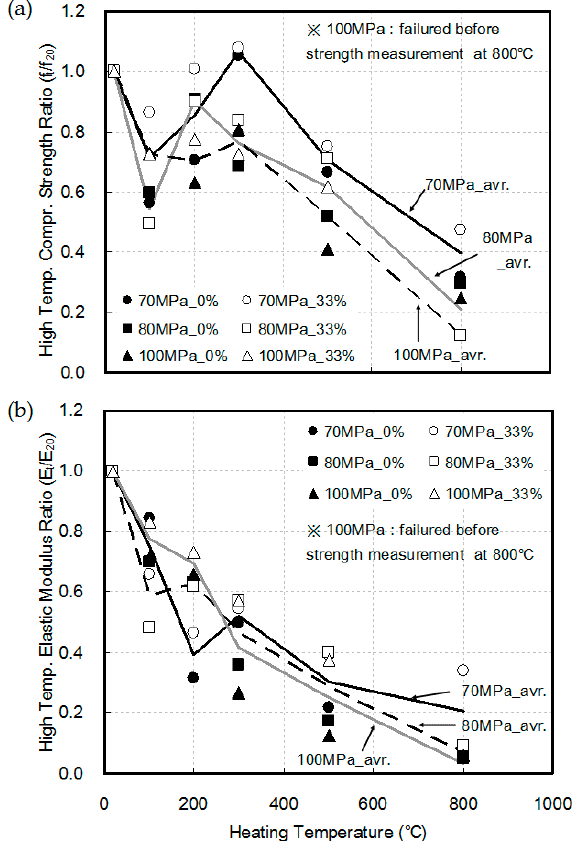
Figure 6. Compressive strength and elastic modulus of high strength concrete at elevated temperatures: ( a ) compressive strength; ( b ) elastic modulus.